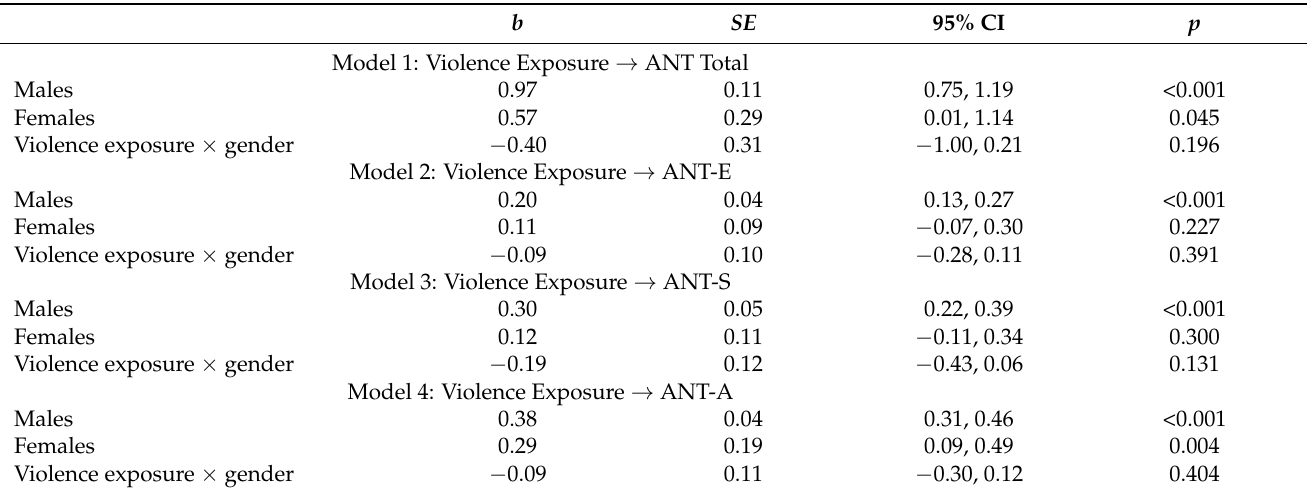
Table 4. Effect of Violence Exposure on Antisocial Features for Males and Females and Interactions between Gender and Violence